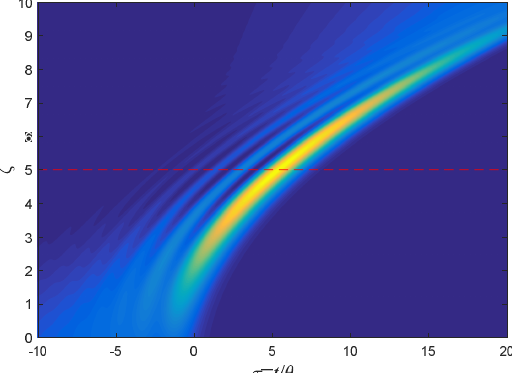
Figure 30. Same as Figure 2, but for the intensity ( | A ( t , z ) | 2 ) of the pulse presented by Equation (97) for a = 0.2/ θ and η / θ = 1. The horizontal line corresponds for the maximum intensity distance z = η / β 2 a .